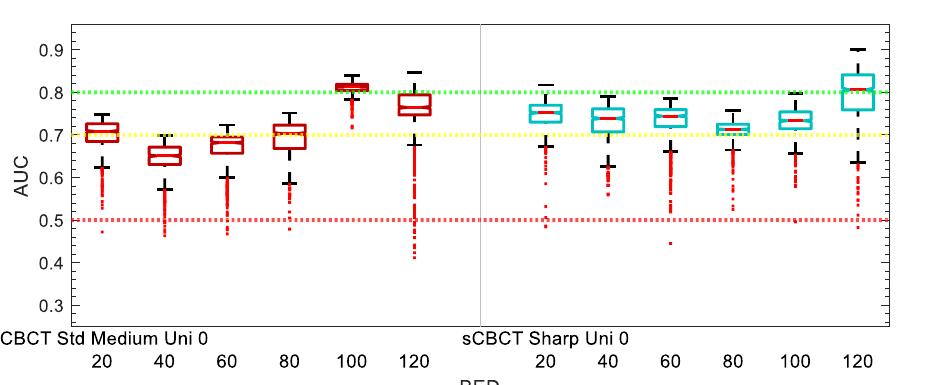
Figure 6. Acute GU Toxicity AUC of delta-radiomic models vs BED bins. The AUC collected over 1000 iterations of the leave-one analysis.